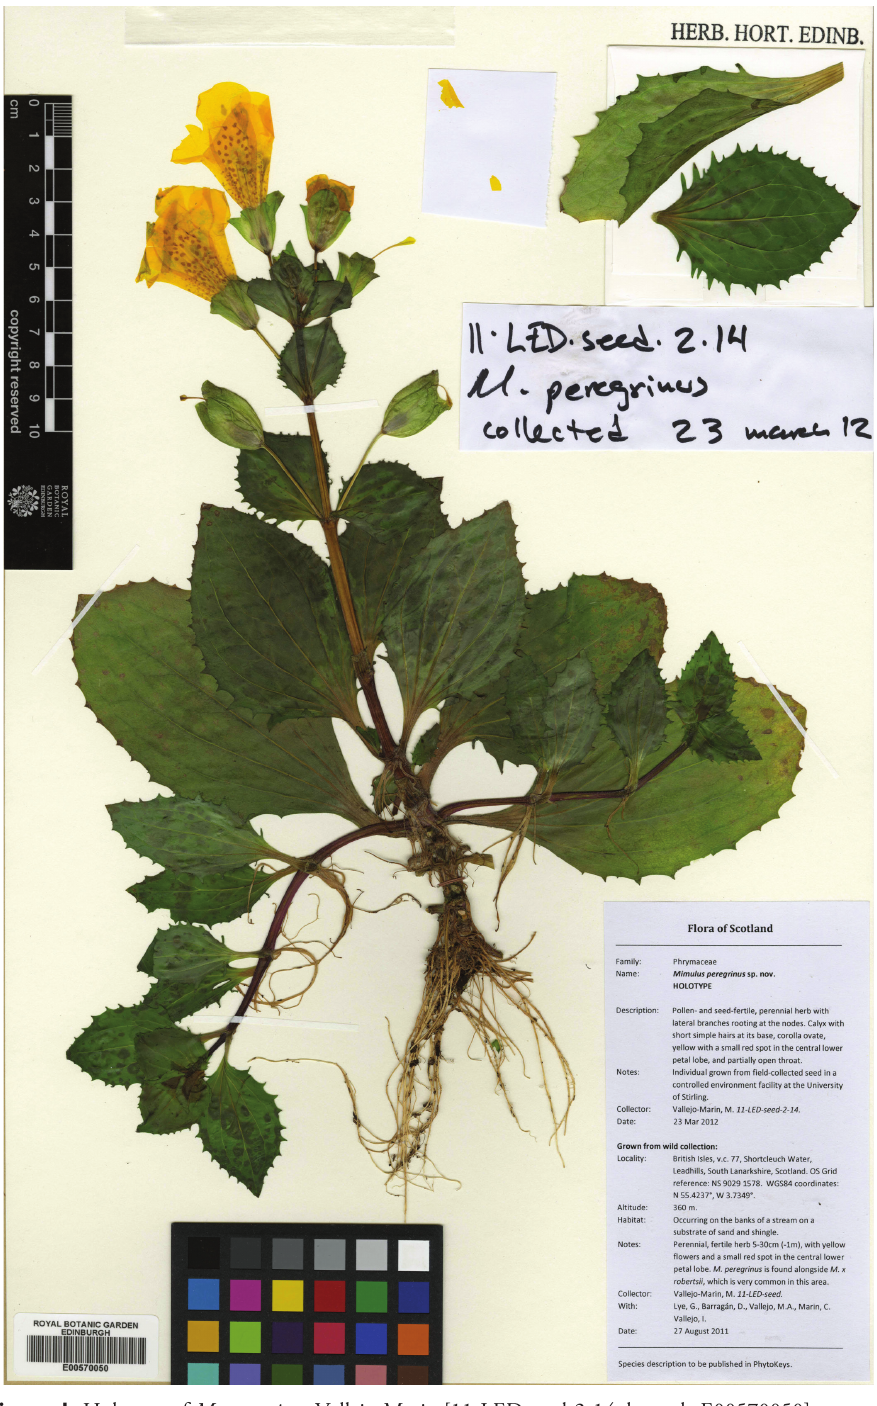
Figure 1. Holotype of M. peregrinus Vallejo-Marin [11-LED-seed-2-14; barcode